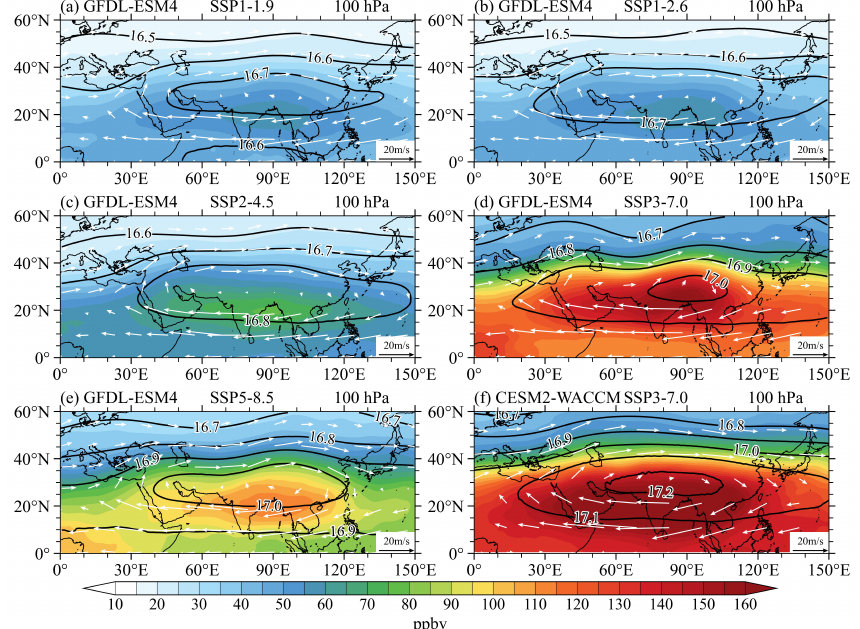
Figure 8. Climatology of CO mixing ratio (color shaded, ppbv) at 100 hPa from simulations of GFDL- ESM4 and CESM2-WACCM for JJA 2100 under different scenarios. Black contours represent geopotential height (GPH) from each model ( a – f ). The white vectors indicate wind field from models ( a – f ).